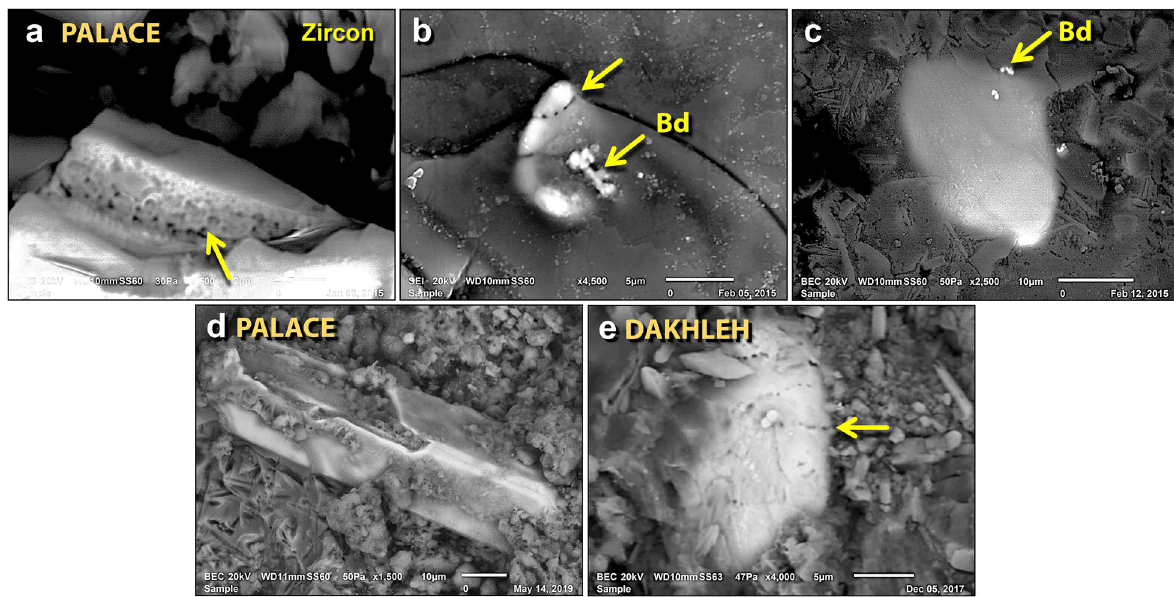
Figure 30. SEM images of melted zircon grains. ( a ) Melted TeH zircon grain with bubbles at yellow arrow due to high-temperature dissociation and/or entrapped porosity. ( b ) Melted TeH zircon grain decorated with bubbles along the fracture line at upper arrow; arrows labeled “Bd” point to bright granular baddeleyite, ZrO 2 , formed during the high-temperature dissociation of zircon. ( c ) Almost fully melted TeH zircon grain mixing into the Ca–Al–Si matrix. ( d ) A typical unmelted zircon grain from TeH with straight, euhedral edges. Grain shows cracks on the top surface from possible thermal or mechanical damage. ( e ) For comparison, from cosmic airburst/impact at Dakhleh Oasis in Egypt: melted zircon decorated with lines of bubbles (arrow).